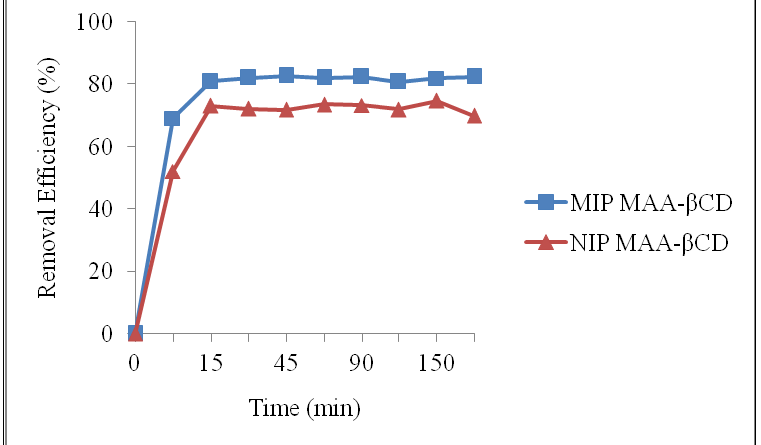
Figure 6. Effect of time on the adsorption of 2,4-DCP onto MIP MAA-βCD and NIP MAA-βCD (Adsorption conditions: adsorbent dose = 20 mg, initial concentration = 10 mg · L −1 , solution volume = 10 mL, T = 298 K, pH =